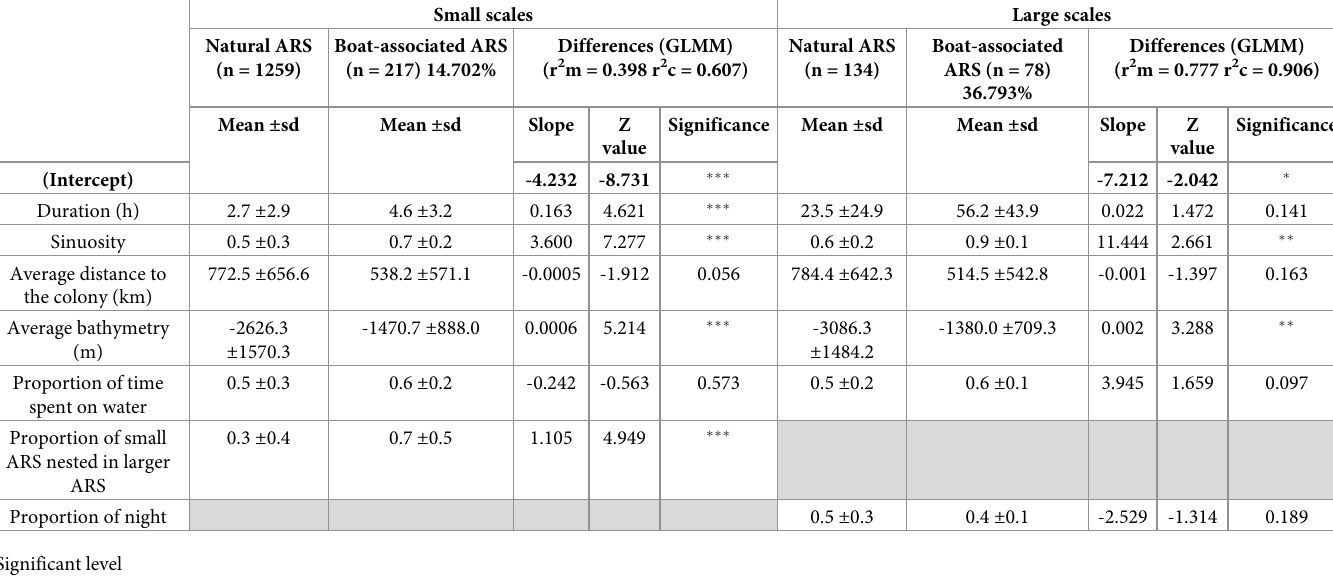
Table 1. Generalised linear mixed model results for differences between small/large scales of natural ARS and boat-associated ARS.